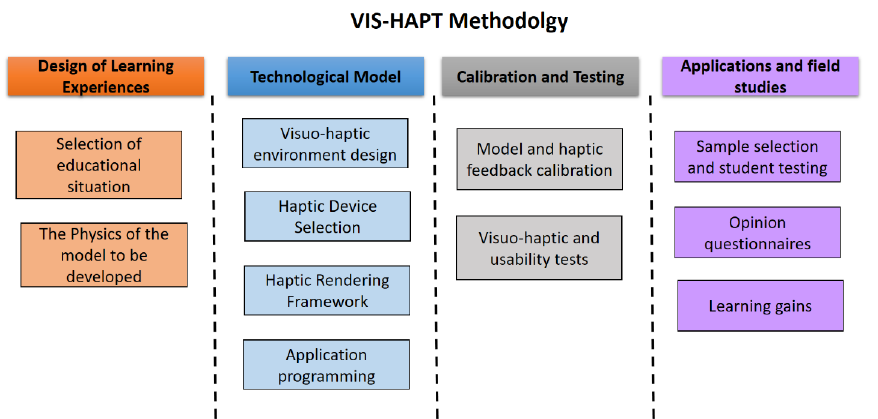
Figure 1. VIS-HAPT methodology. The diagram shows the four major phases of the development of visuo-haptic environments in Education 4.0: (a) design of the learning experience; (b) technological model; (c) calibration and testing; and (d) application and field